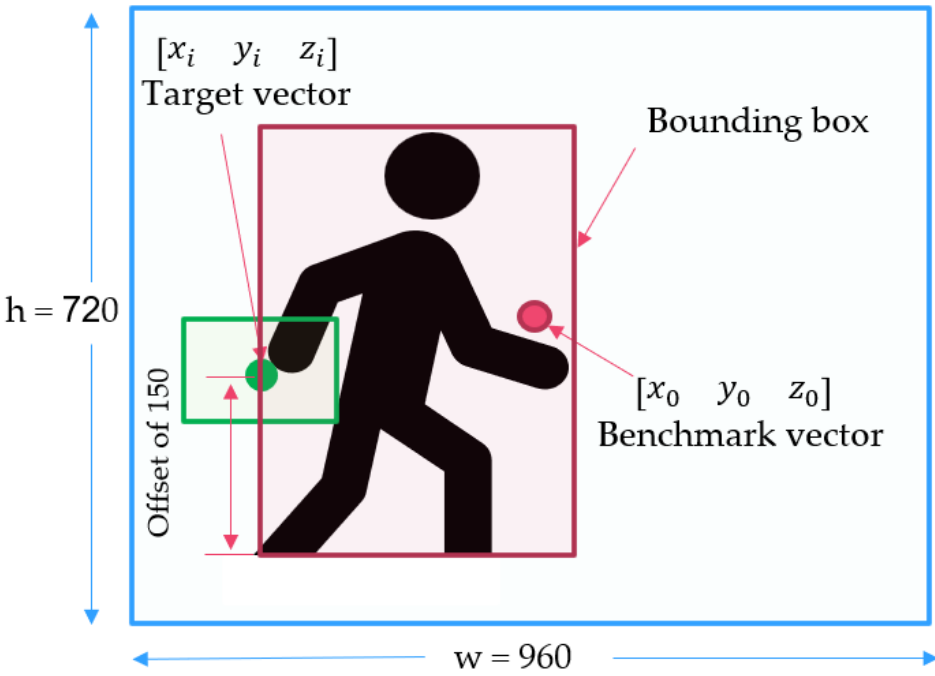
Figure 6. Target vector and benchmark